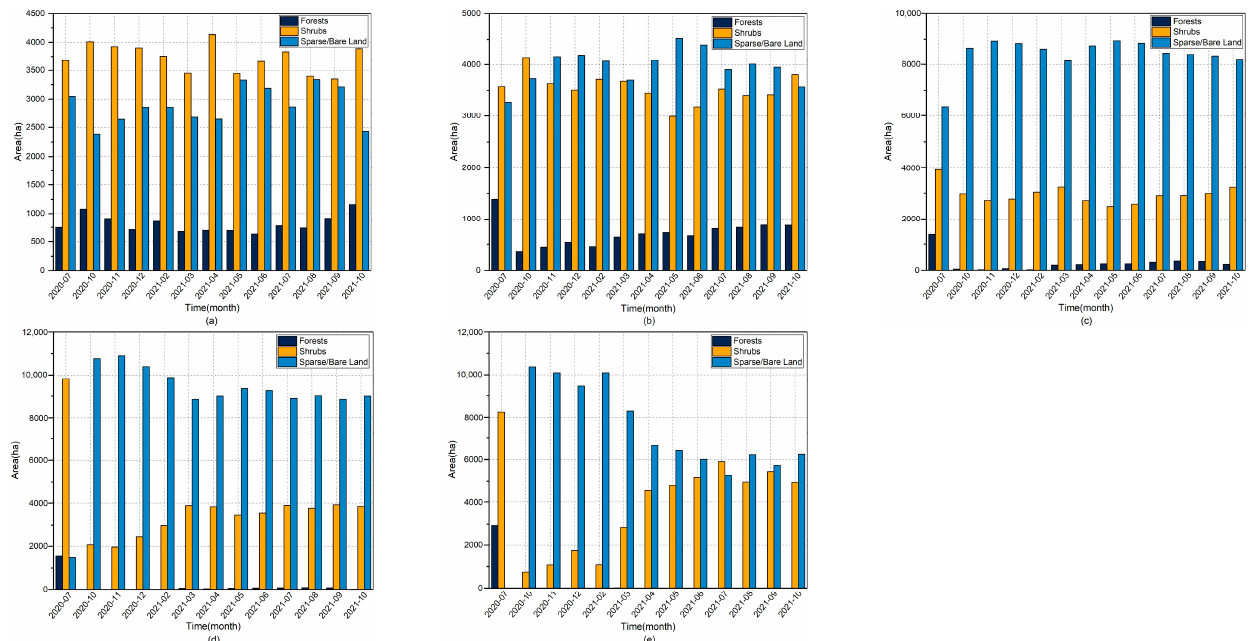
Figure 15. Vegetation regeneration under different burn severities: ( a ) unburned/very low; ( b ) low; ( c ) moderate; ( d ) high; and ( e ) very high.